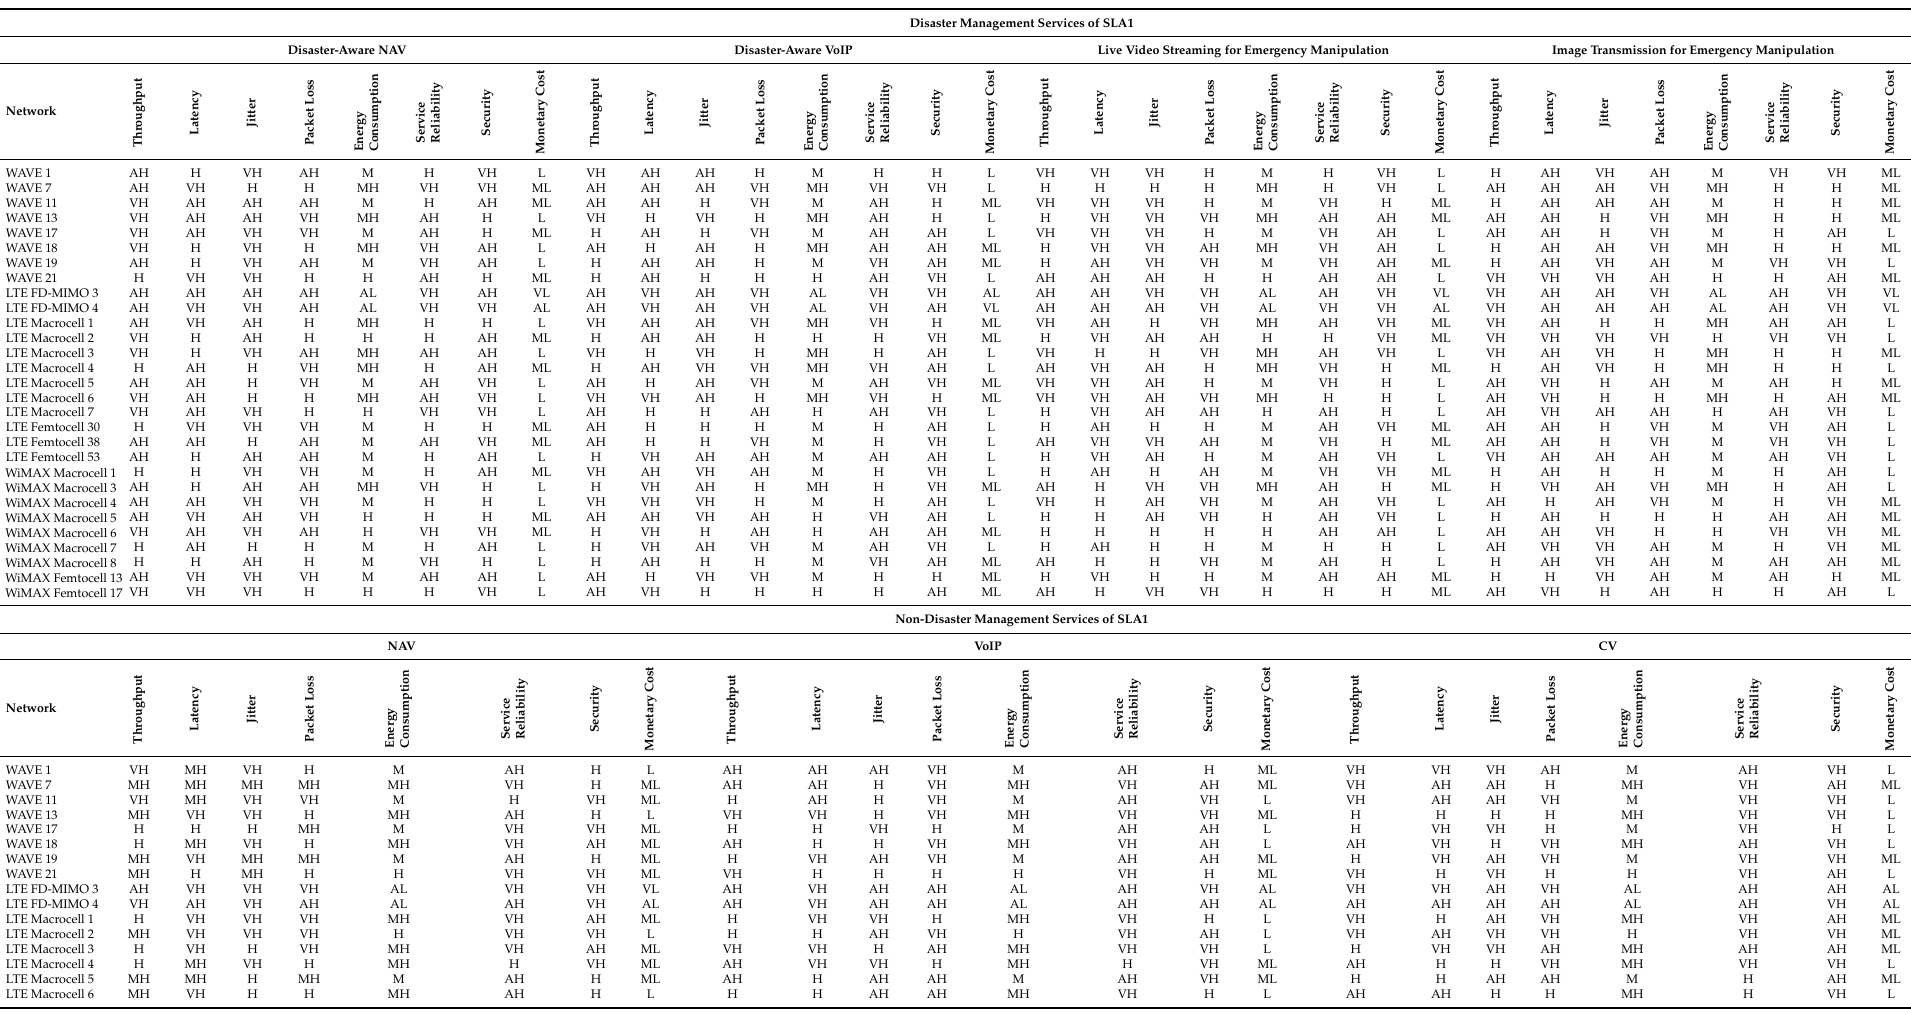
Table A5. The networks of SLA1 considered in the study of the simulation